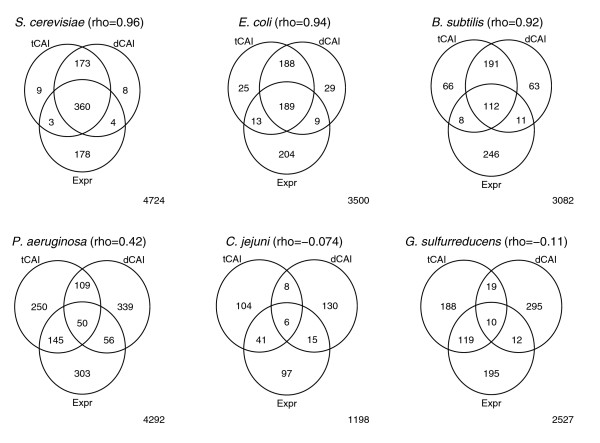
Venn diagram evaluating the prediction of highly expressed genes (tCAI and dCAI) by comparison with microarray gene expression data (Expr). The overlap between genes with top 10% tCAI, dCAI, and Expr values are pictured as overlapping circles, in which the number of genes found by either method is given. The organisms are sorted in order of decreasing correlation (rho) between tCAI and dCAI values based on all genes in each organism. For organisms with high correlation (high rho) between tCAI and dCAI values, most genes are predicted as highly expressed by both measures. Moreover, these predictions overlap significantly with genes found to be highly expressed experimentally by microarrays. For organisms with low correlation (low rho) between tCAI and dCAI values, few genes are predicted as highly expressed by both measures. Here, more genes predicted as highly expressed by tCAI are found to be highly expressed by microarrays than for dCAI. dCAI, dominant codon adaptation index; tCAI, translational codon adaptation index.